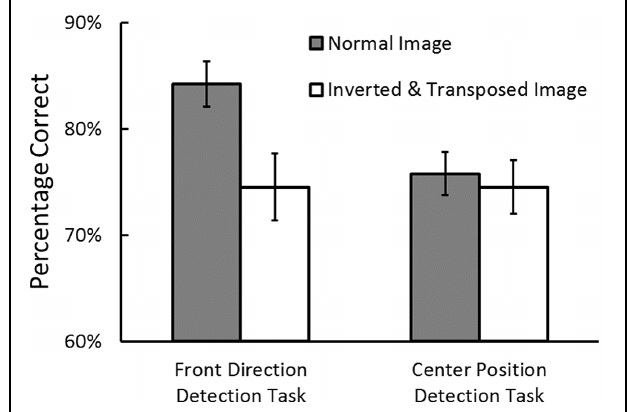
FIGURE 5 | Percentage of correct responses for the front direction detection task and center position detection task in Experiment 3. Error bars indicate standard